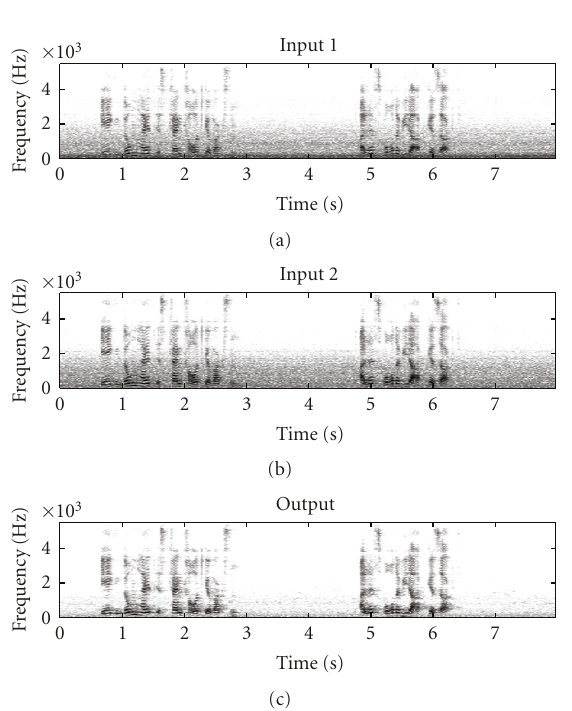
Figure 11: Spectrograms of the input and output signals with the SC + FLMS approach (car speed of 100km/h, ρ =